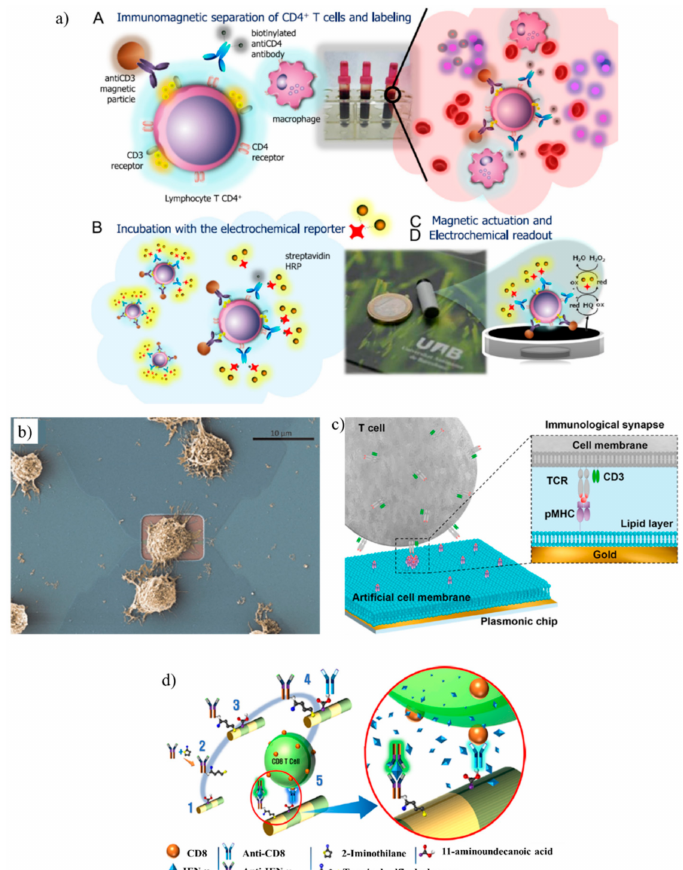
Figure 3. ( a ) Schematic representation of a magneto-actuated biosensor where commercial magnetic particles were modified with an anti-CD3 antibody to isolate CD4 + cells from monocytes and macrophages. Biotinylated anti-CD4 antibodies labeled with streptavidin-horseradish peroxidase (HRP) were used to label the isolated CD4 + cells. The amperometric measurement was mediated by H 2 O 2 and hydroquinone (adapted with permission from [93], Copyright Elsevier 2015). ( b ) Example of a cytotoxic T cell adhered on top of a transistor gate with a dimension of 12 × 5 mm 2 (adapted